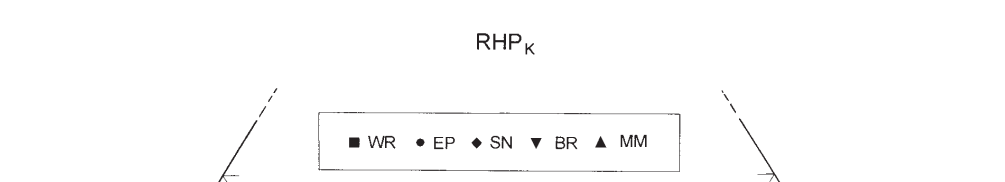
Fig. 4. Thermal conductivity values versus porosity.